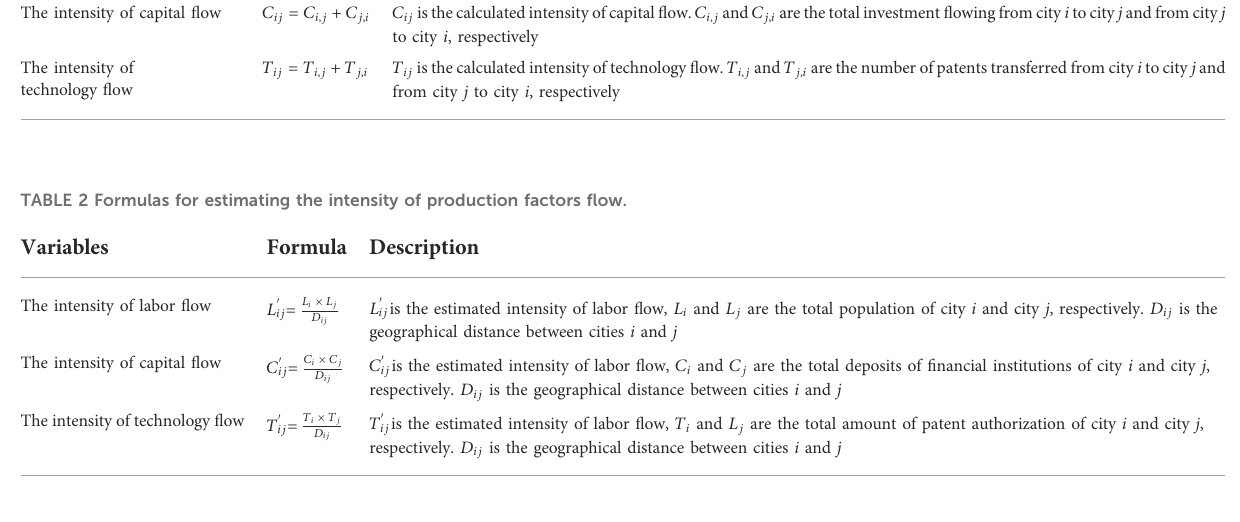
fl ow between cities. Table 1 shows the formulas for calculating the fl ow intensity of three kinds of production factors.